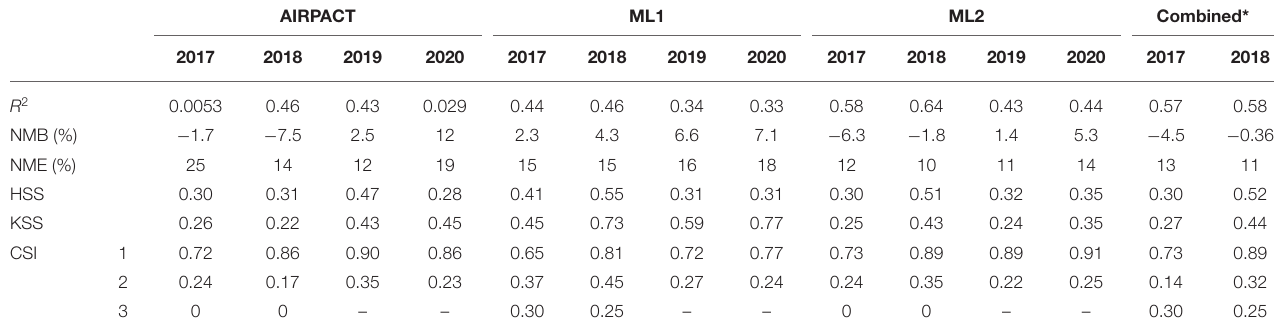
TABLE 5 | Annual statistics and forecast verifications of the 10-time, 10-fold cross-validations at Kennewick, WA. AIRPACT